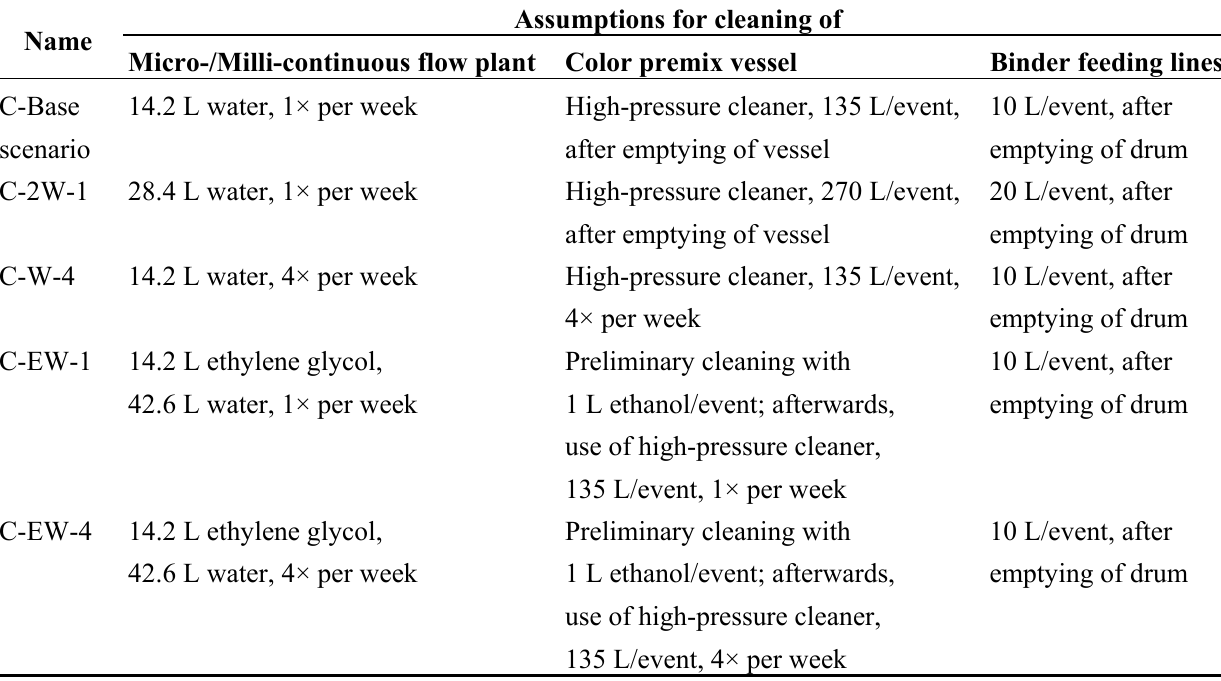
Table 2. Options of the sensitivity analysis regarding the required amount of cleaning agents for the micro-/milli-continuous campaign